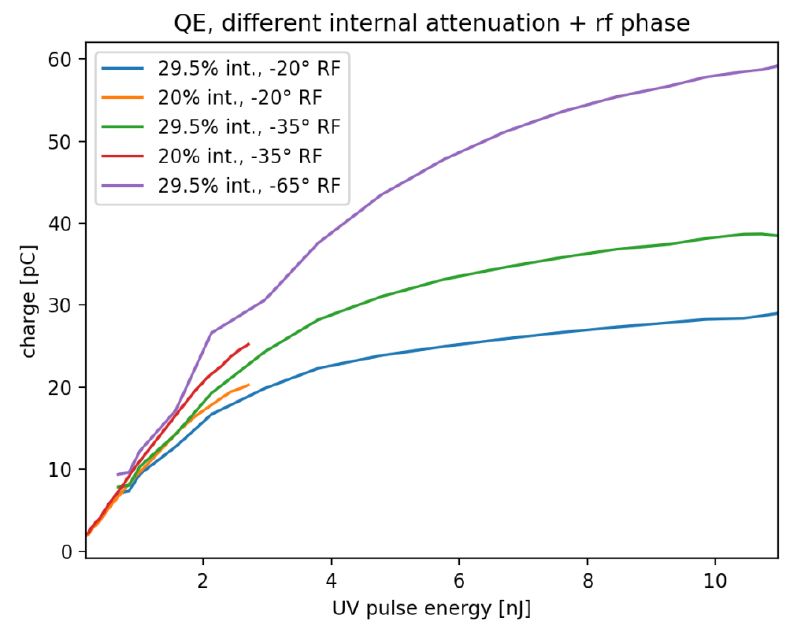
Figure 5. Charge measurement during a scan of the photoinjecor laser pulse energy at the photocath- ode surface for different laser attenuator positions and RF phases in the gun